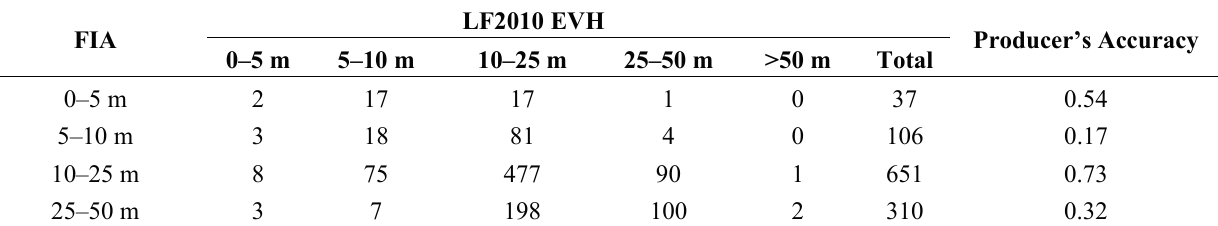
Table 6. Confusion matrix for LF2010 EVH and FIA